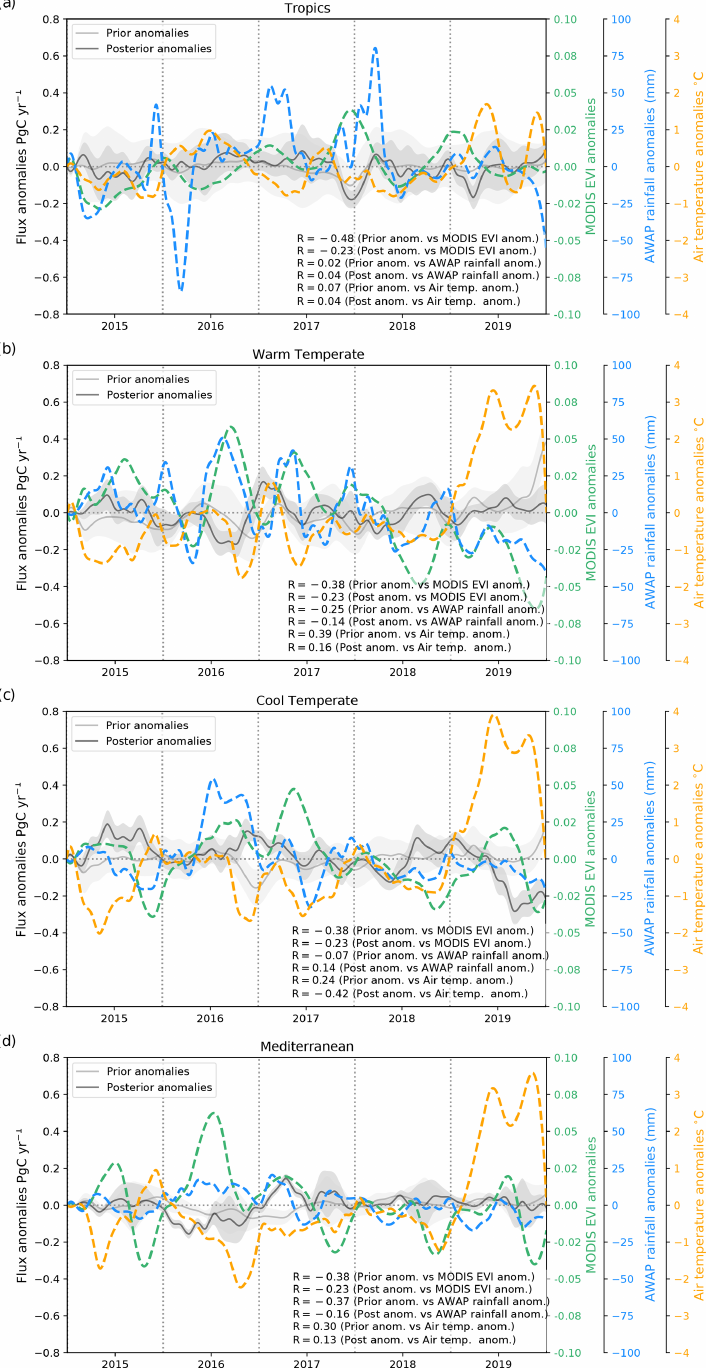
Figure D1. Time series of the 3-month running mean posterior (black line) and prior (grey line) terrestrial CO 2 flux anomalies (PgCyr − 1 ) and 3-month running mean EVI anomalies (turquoise dashed line) between 2015 and 2019 aggregated by four agroclimatic regions: (a) tropics, (b) warm temperate, (c) cool temperate, and (d) Mediterranean. The grey shaded area represents a 1.0 standard deviation range around the mean for the prior and posterior flux